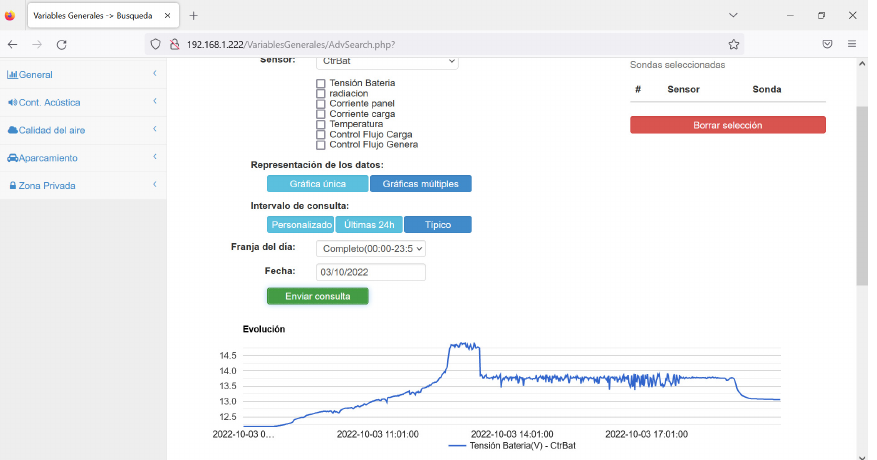
Figure 10. Evolution of battery voltage monitored in the platform.